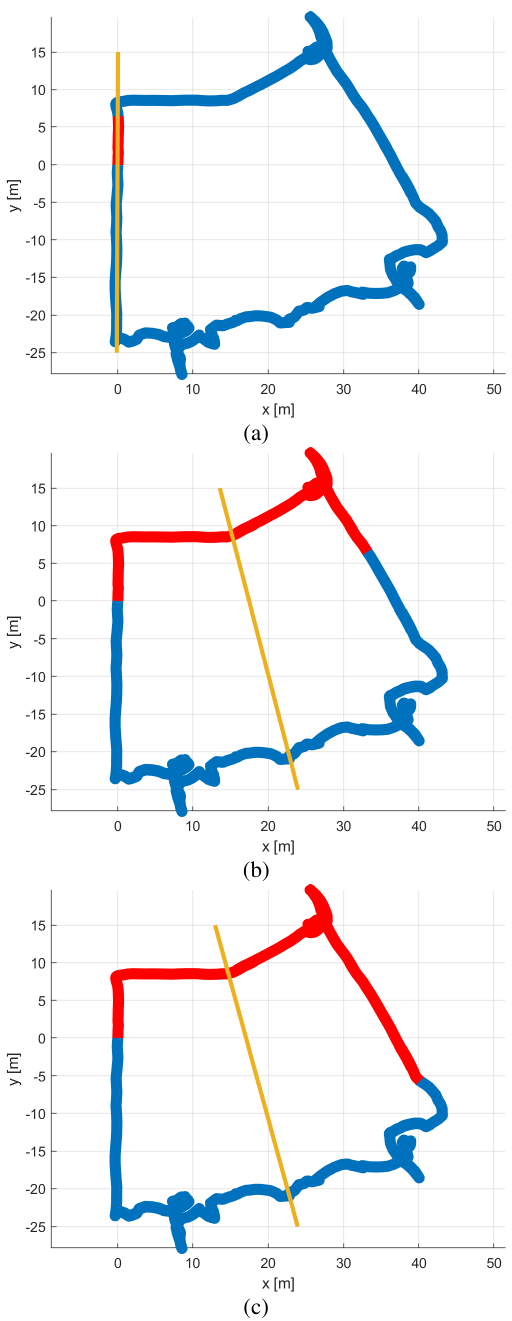
Figure 3. Symmetries in the building detected and/or improved with the increase of the collected data: planes associated to the estimated symmetries are shown as solid yellow lines, data used to estimate them are shown in red, whereas the overall device trajectory is shown in blue. Examples of assessed symmetries: (a) symmetry between the two sides of the initial corridor, (b) initial estimate of the symmetry on all the building, (c) improved estimate of that already shown in